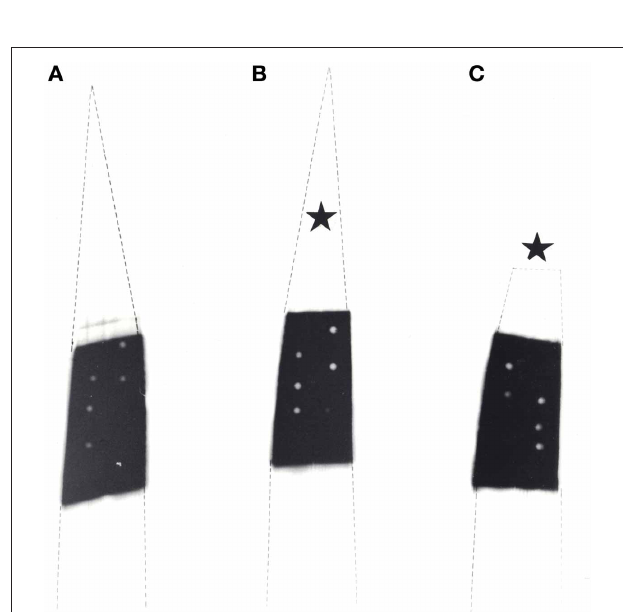
FIGURE 5 | Microautoradiographs of leaf areas which were exposed to 14 CO 2 . (A) In the unstimulated leaf, label is concentrated in bundle sheath cells (B) . (B) In leaves which were cold-shocked at their tips label concentrated at the cell walls between mesophyll (M) and bundle sheath cells (arrows). (C) In tip-wounded leaves label was more or less distributed equally in all living cells. There was a slight accumulation, however, at the mesophyll/bundle sheath cell wall. P, phloem; PX, protoxylem; V,